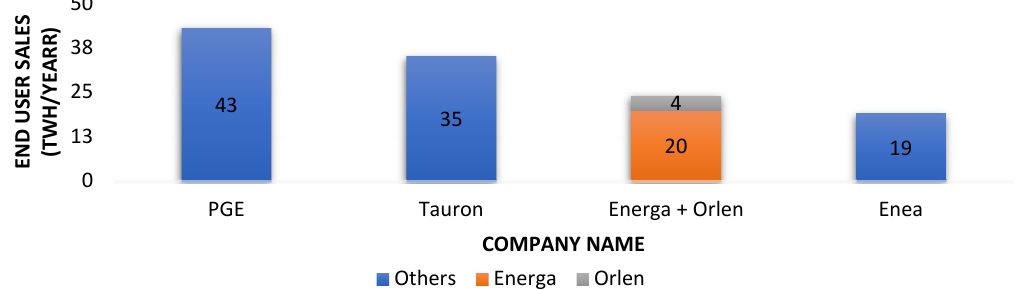
Figure 7. Electricity market after Energa acquisition by Orlen-end-user sales [TWh/Year]. Source: author’s study based on: https://wysokienapiecie.pl/24792-orlen-chce-przejac-energe/ (access date: 15 August 2021).